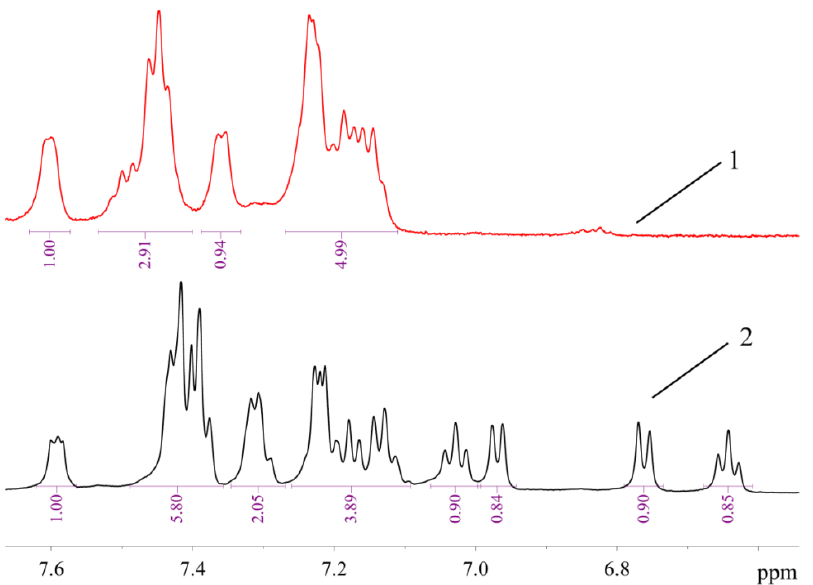
Molecules 2021 , 26 , x FOR PEER REVIEW Figure 7. The 1 H-NMR spectra of 1 (1) and 2a (2) in DMSO- d 6 (region of H atoms of aromatic systems). Figure 7. The 1 H-NMR spectra of 1 (1) and 2a (2) in DMSO- d